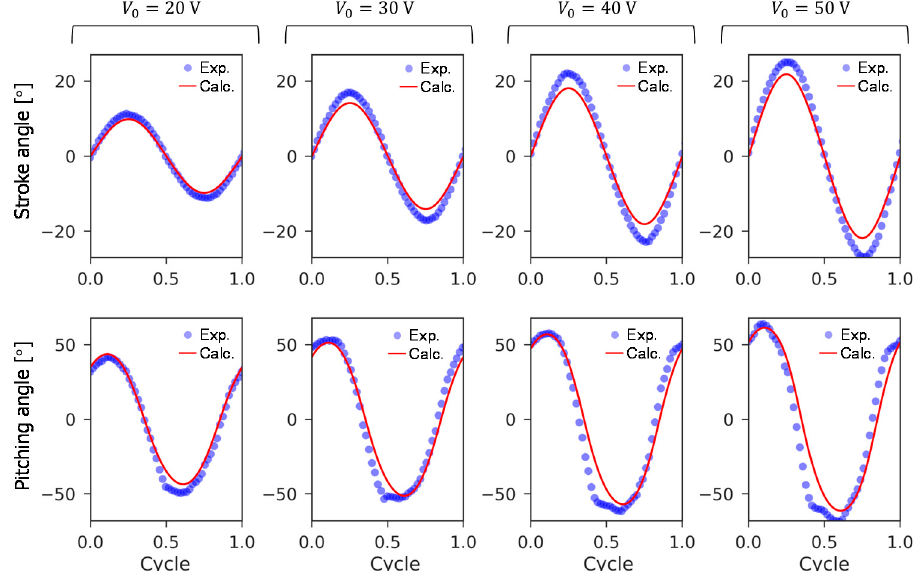
Figure 12. Measured and calculated stroke and pitching angle of large-type actuator: blue circle and red line show experimental data and calculated result, respectively.